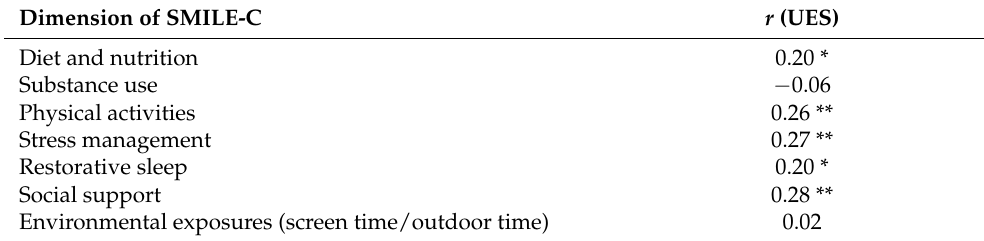
Table 5. Examining discriminant validity by dimension of SMILE-C and